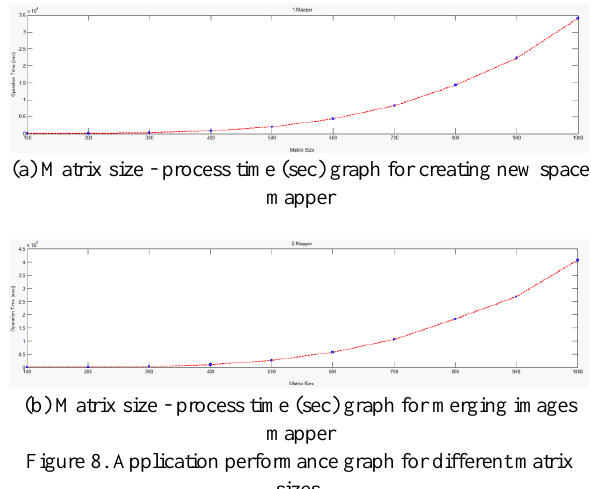
Figure 8. Application performance graph for different matrix